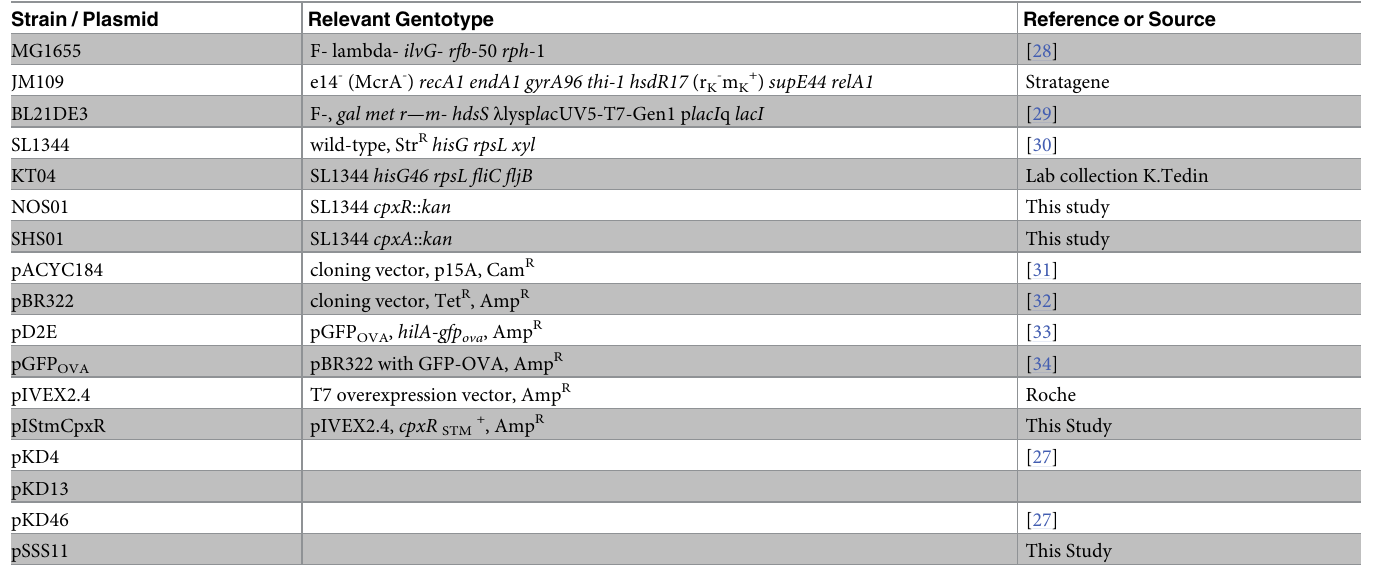
Table 1. E . coli strains and plasmids used in this